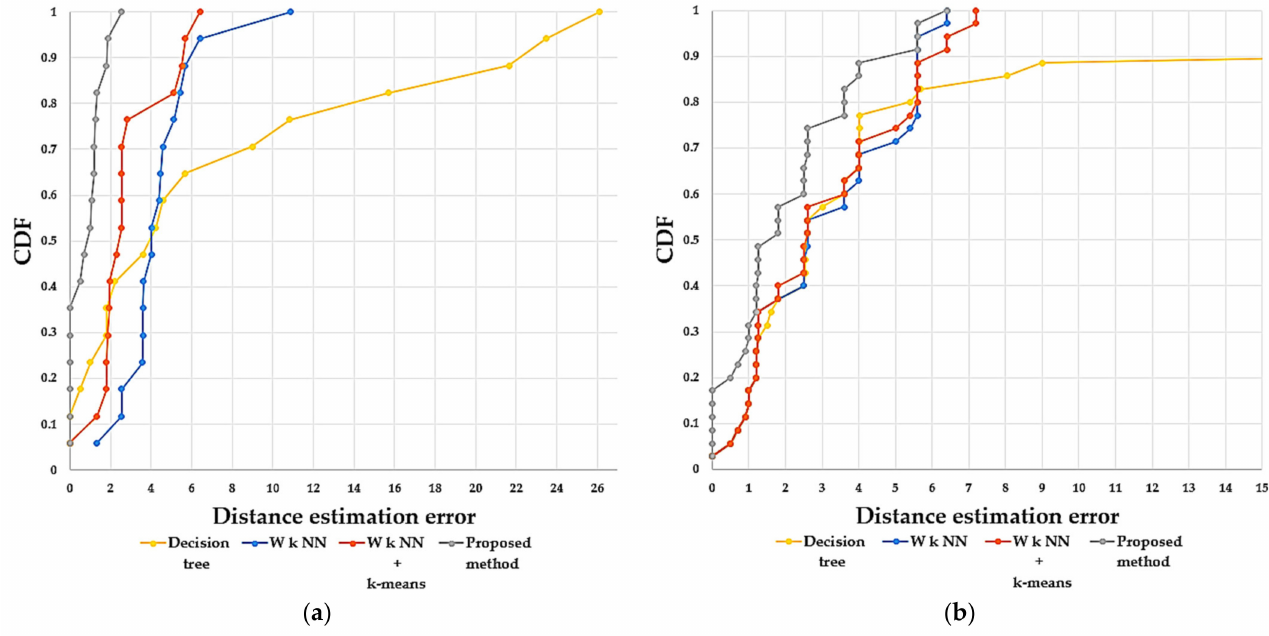
Figure 12. CDF of distance estimation error. ( a ) Experimental environment 1. ( b ) Experimental environment 2. The X-axis represents the error distance in meters, and the Y-axis represents the probability of